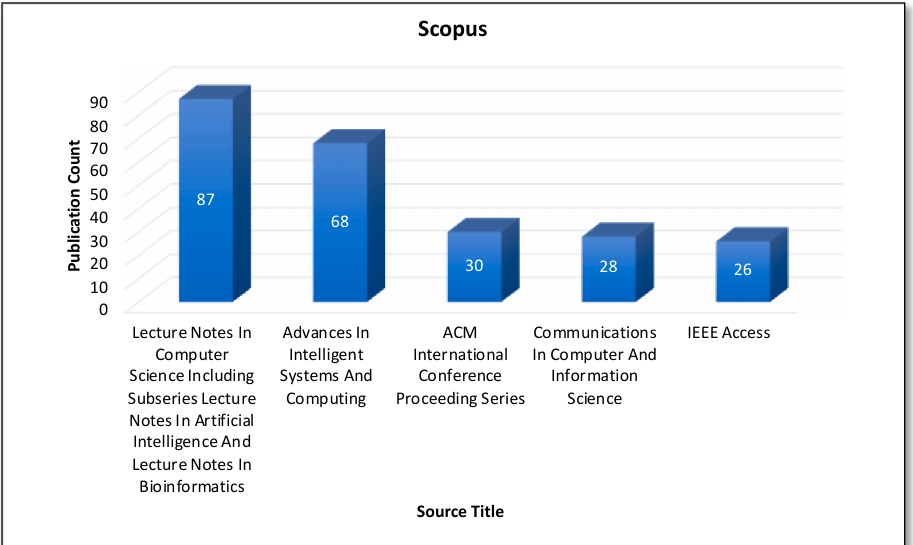
Figure 11. Analysis of publications by source (Scopus database).